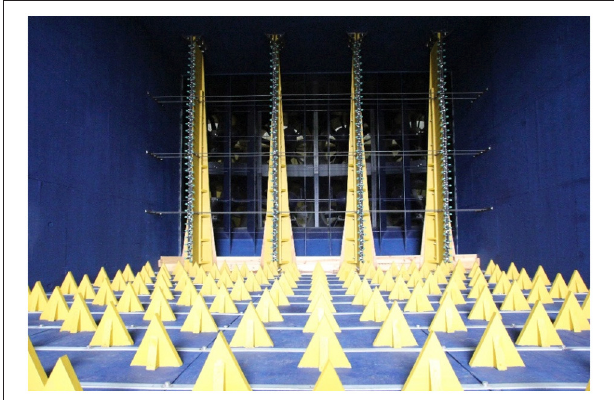
FIGURE 1 | Spires and roughness elements in the WOW at FIU,